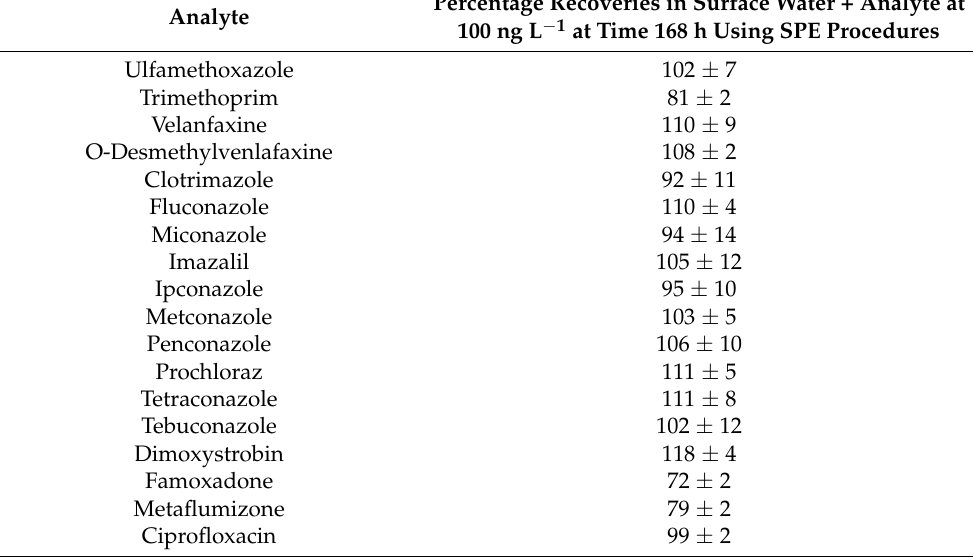
Table 9. Percentage recoveries in Surface Water + analyte a 100 ng L − 1 at time 168 h using SPE procedures.